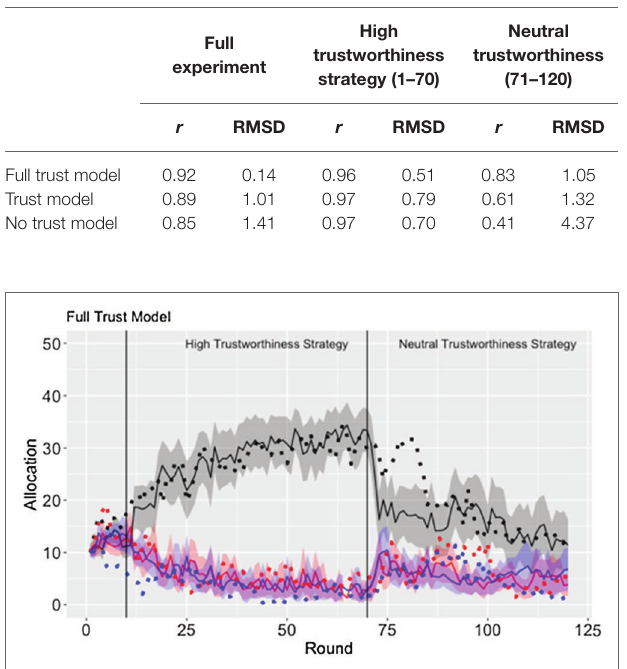
FIGURE 5 | The model fit (dotted line) to the participants’ average allocation ±95% CI (solid line and ribbon) to the confederate agents on the high (black), medium (red), and low (blue) interaction